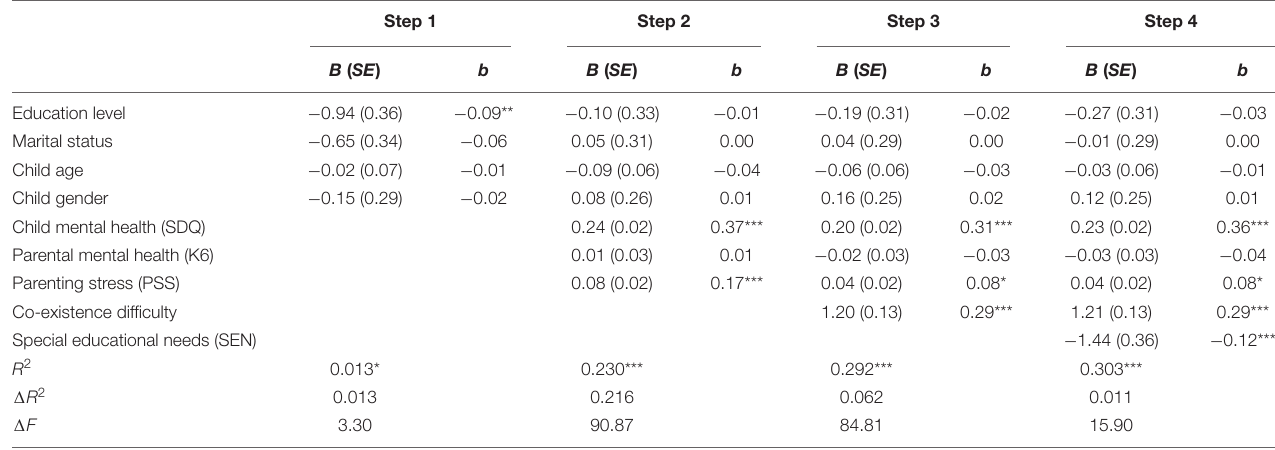
FIGURE 3 | Change in children’s physical activity. TABLE 3 | Hierarchical regression summary predicting children’s externalizing behavior change before and during the lockdown in the United